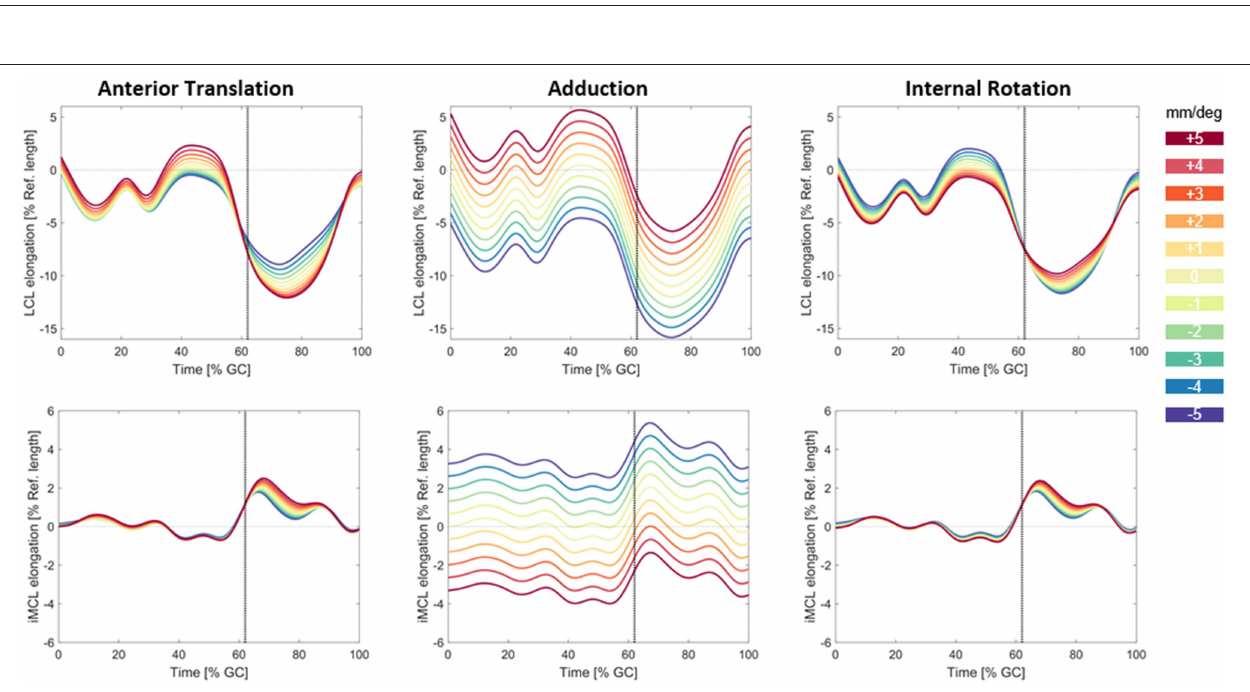
FIGURE 8 | Variation in the LCL and iMCL elongation due to changes in anterior/posterior translation (left) , abduction/adduction rotation (middle) , and internal/external rotation (right) of the implant. The base line kinematics captured from a subject with PS design prosthesis during level walking was perturbed in the range of ( ± 5 mm/ ± 5 ◦ ). The vertical dotted line shows the instant of Toe-off.